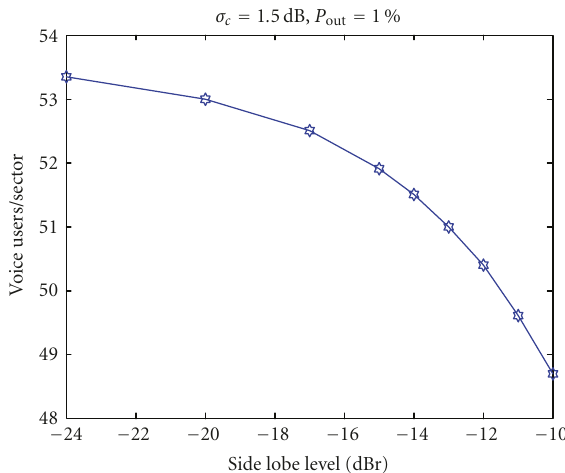
Figure 7: Mixed capacity of the sector.